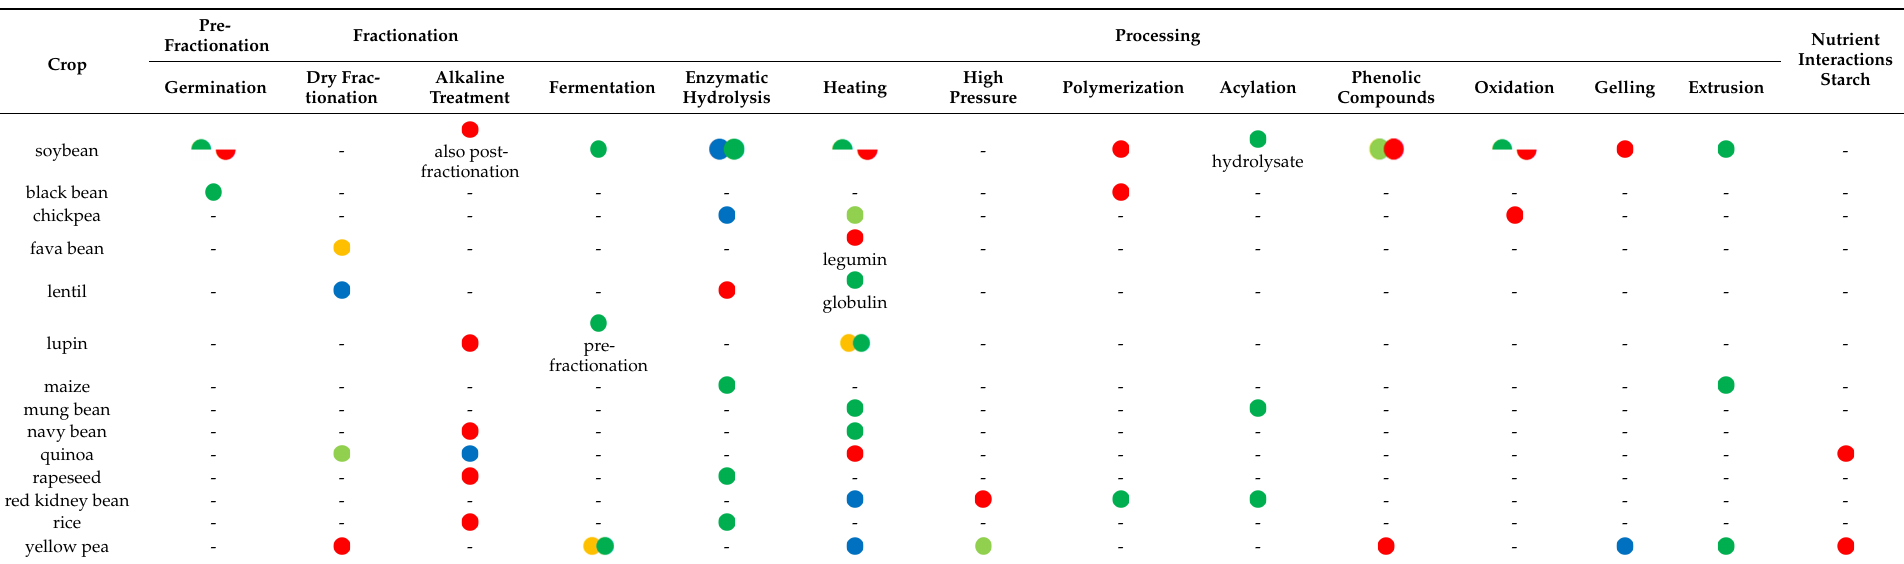
Table 1. Overview of the effect of different types of processing before, during or after protein fractionation from different crops. , negative; , positive; or this